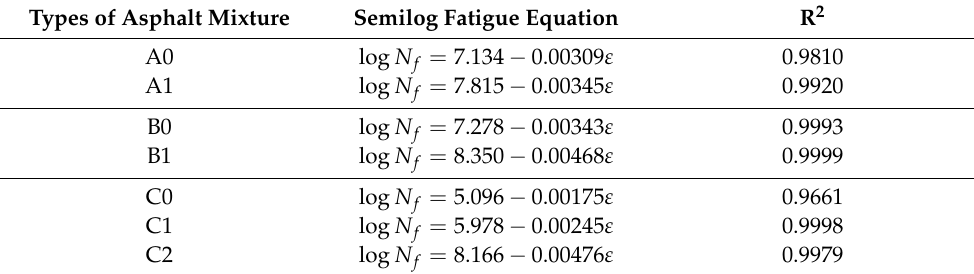
Table 5. Semilog fatigue equation of different asphalt mixtures.